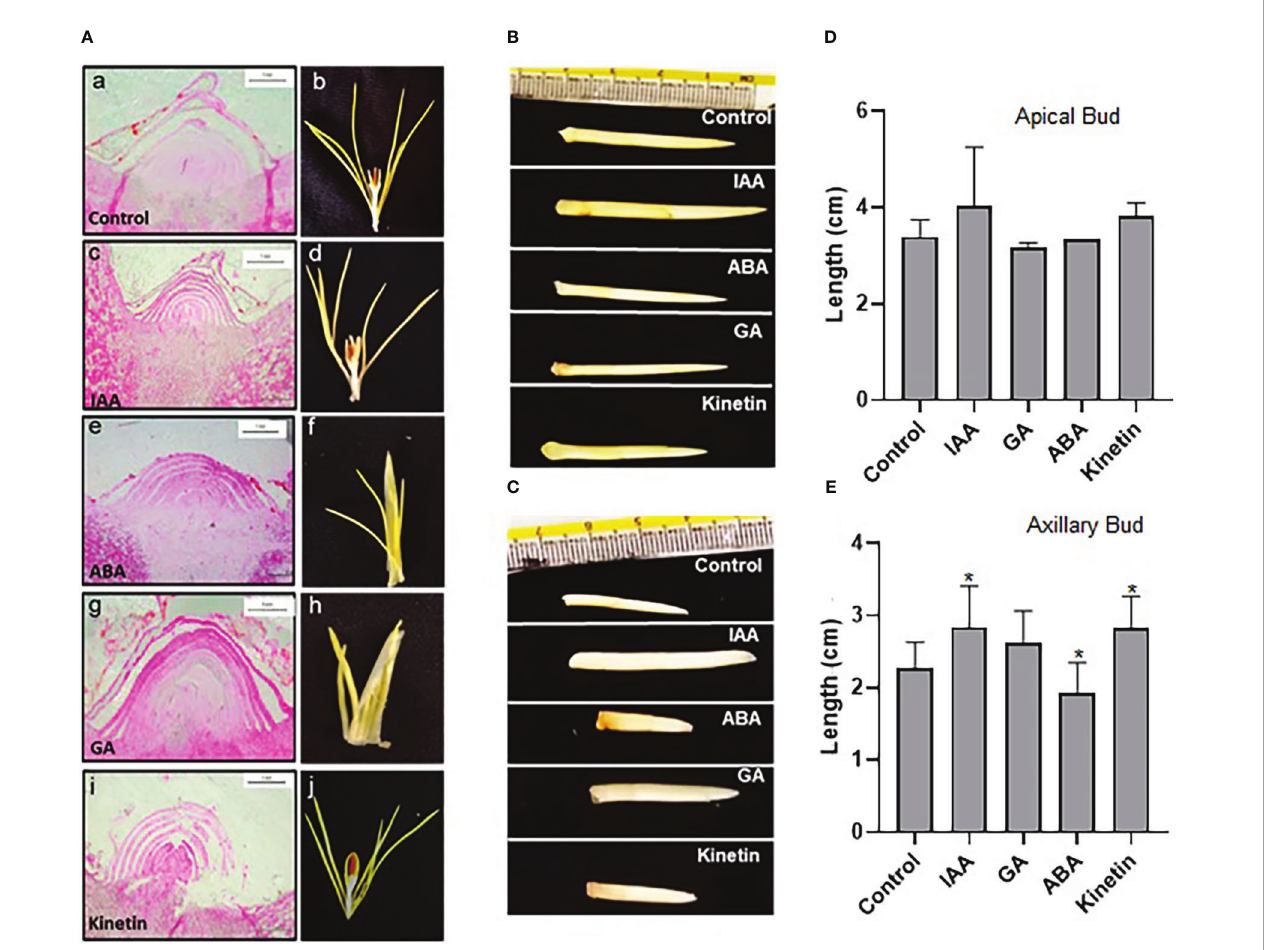
FIGURE 2 Morphological characteristics of saffron apical bud during fl ower induction stages after the hormonal treatments. (A) Cross-section images of the apical bud after 45 and 90 days of hormonal treatments, representing stage I and stage II, respectively: a, b — control (mock treatment); c, d — IAA-treated; e, f — ABA-treated; g, h — GA-treated; and i, j — kinetin-treated in stage I and stage II, respectively. (B, C) Representative pictures of the apical bud and axillary bud, respectively, in stage II of treatments. (D) Graphical representation of apical bud length. (E) Graphical representation of axillary bud length in stage II. The data presented is the mean of three biological replicates. Error bars represent standard error. * P < 0.05, with respect to control (Student ’ s t